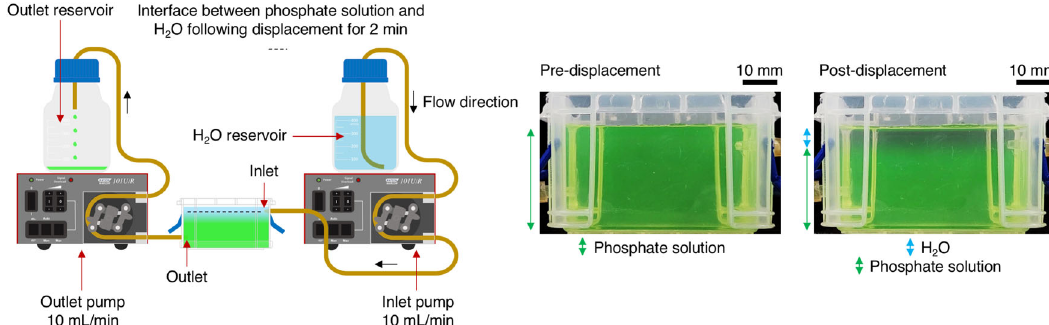
Fig. 1 Displacement of phosphate solution with H 2 O. Phosphate solution was labelled with fl uorescein to make it appear green in colour in contrast to clear H 2 O. Density forces were found to drive separation of the miscible liquids, resulting in the establishment of a layer of H 2 O on top of the